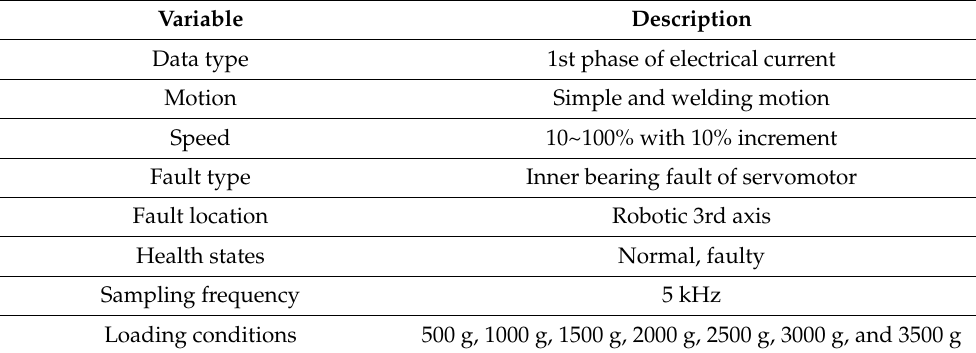
Table 2. Experimental